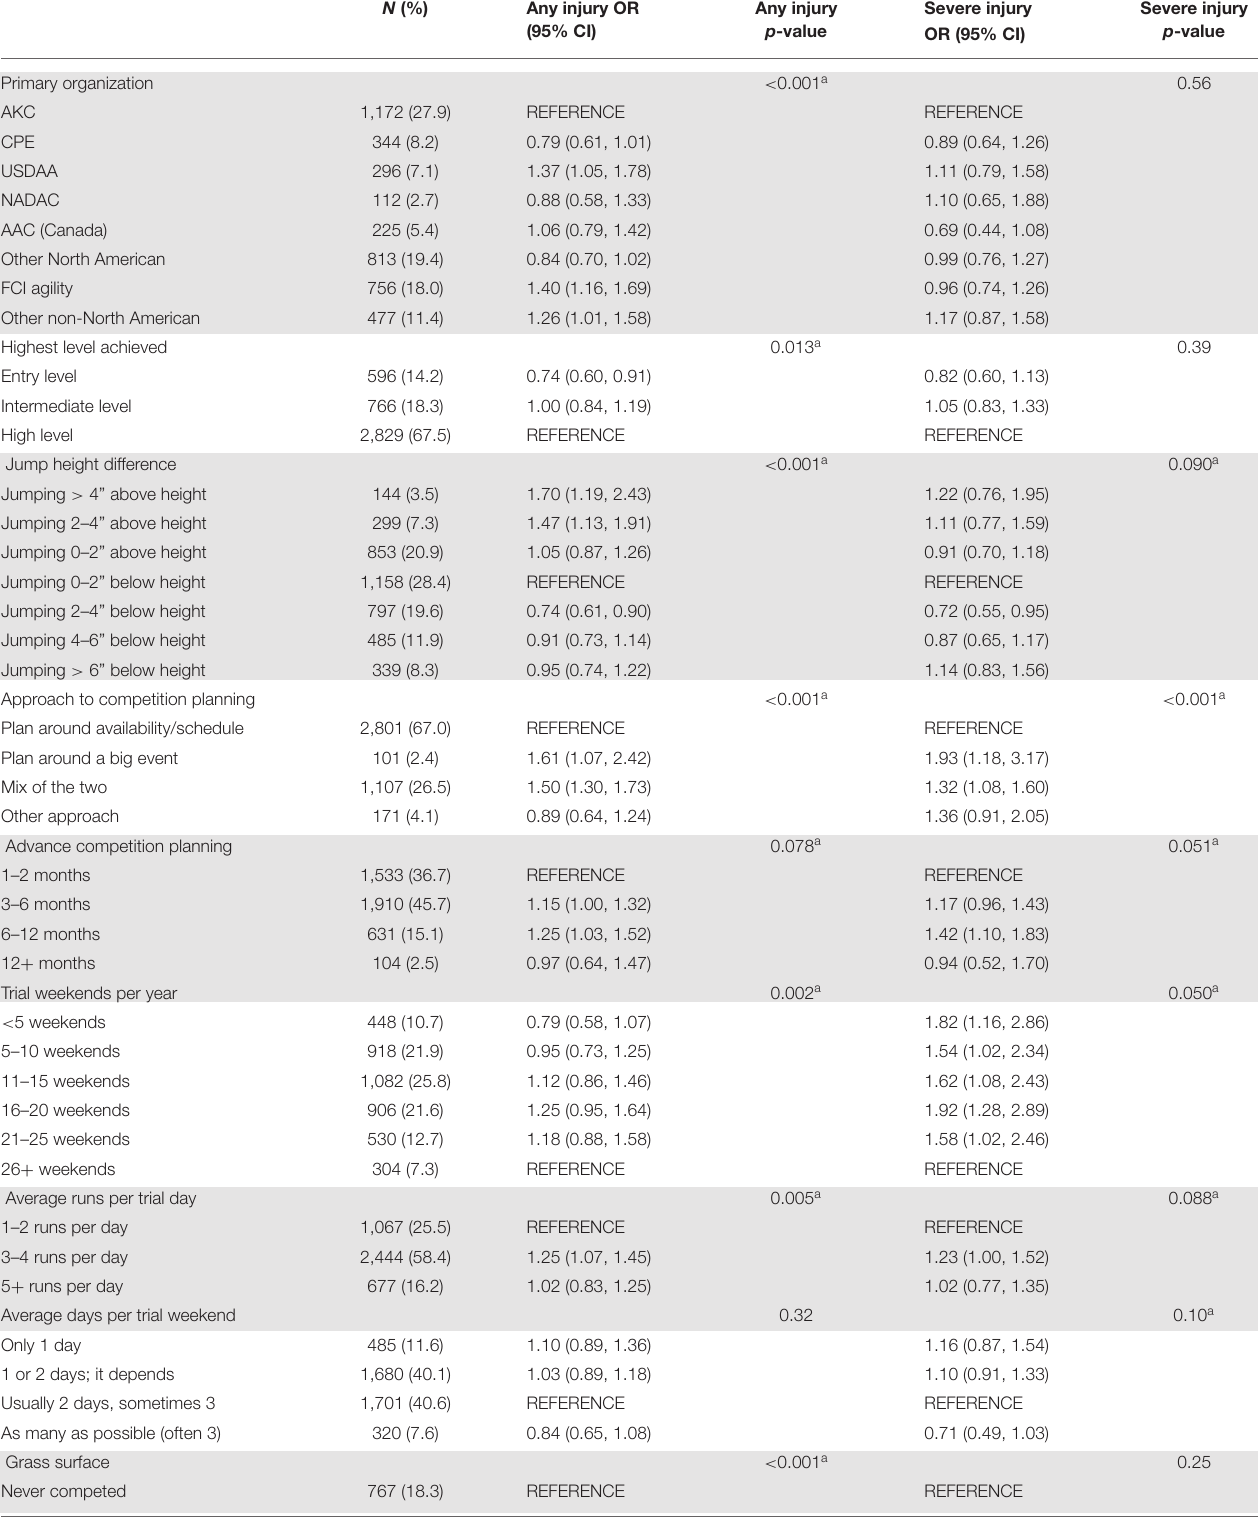
TABLE 1 | Age adjusted associations between competition risk factors and injury